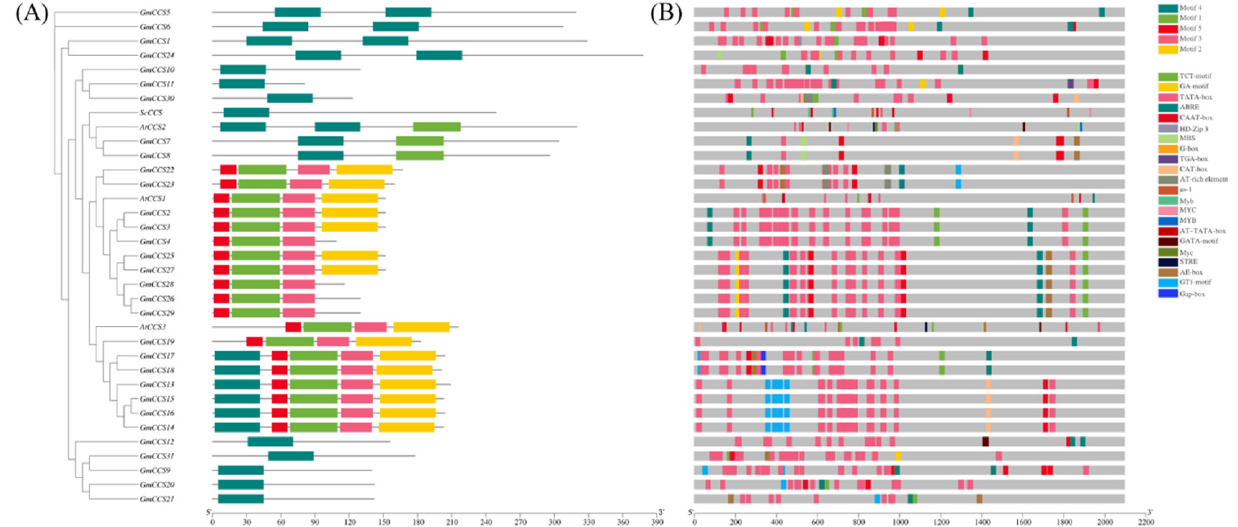
Figure 4. ( A ) The motifs in GmCCSs’ protein. Boxes 1–5 represent motifs 1–5, the grey line indicate the non-specific functional area. ( B ) Visualization of hormone-responsive elements in GmCCSs pro- moters by TBtools, including position, kind and quantity of elements.